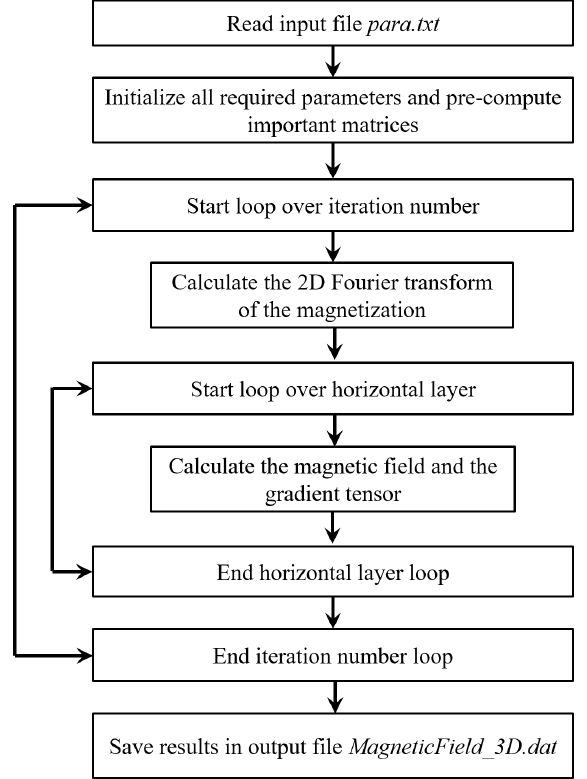
Figure 3. Basic structure of the main program. Table 1. Subroutines for modeling the magnetic gradient tensor at high